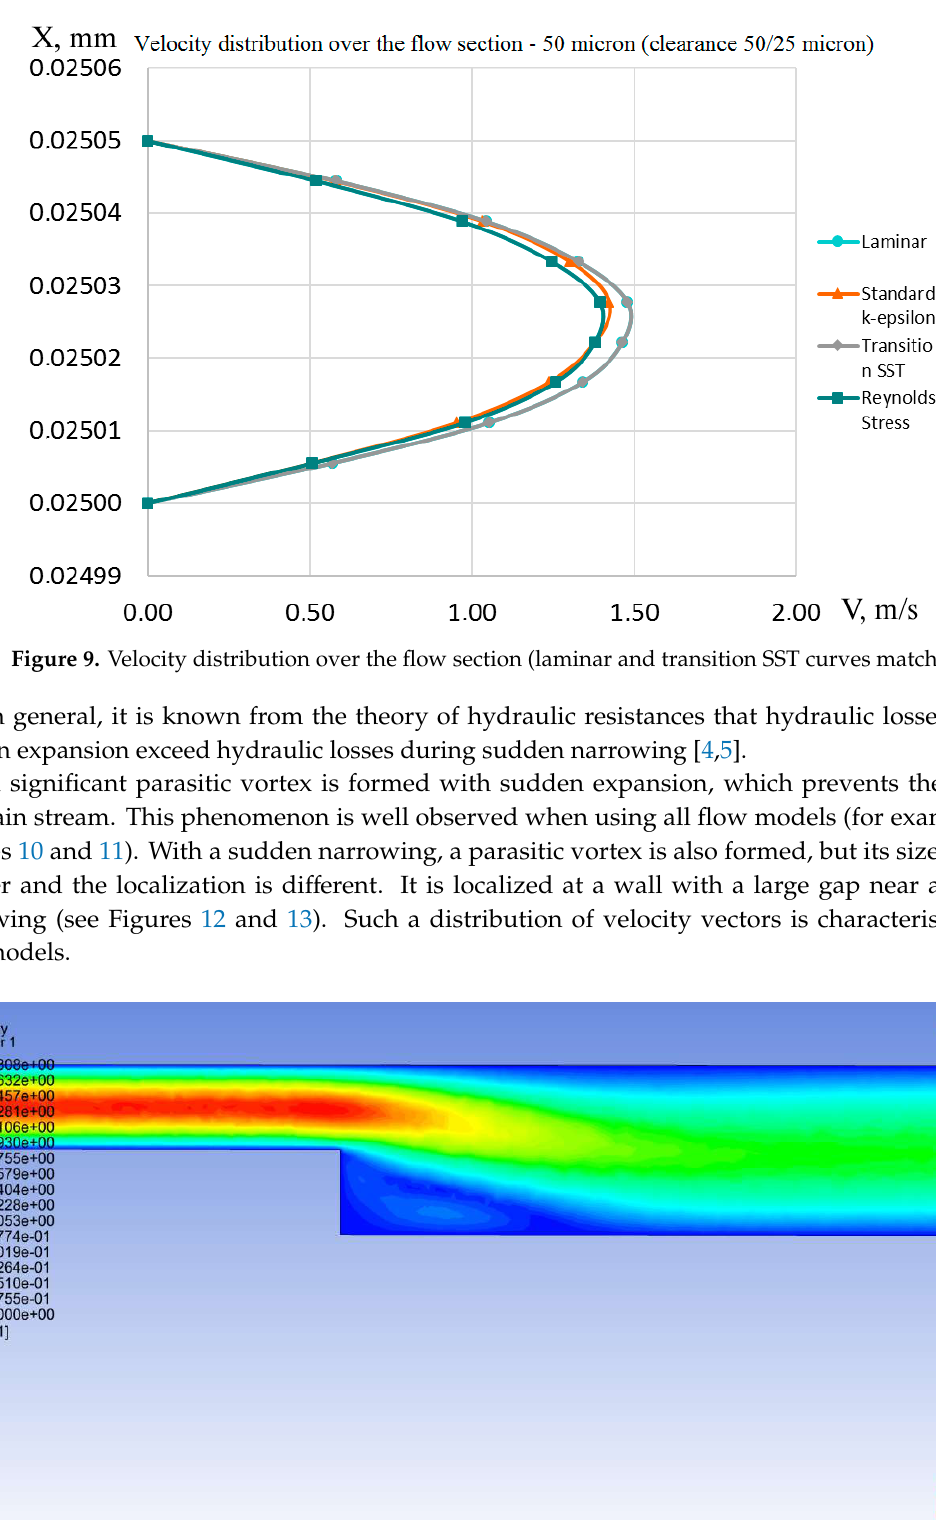
Figure 11. Velocity vector distribution in the Reynolds Stress turbulence model.